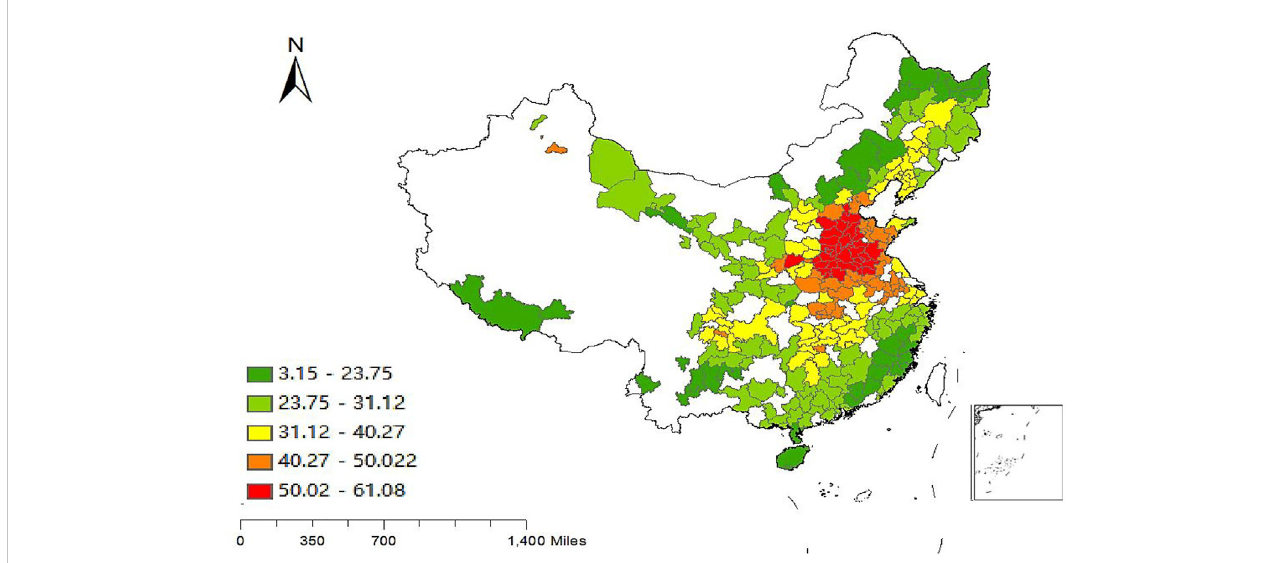
FIGURE 4 Spatial distribution of annual average PM2.5 concentration in 2019.